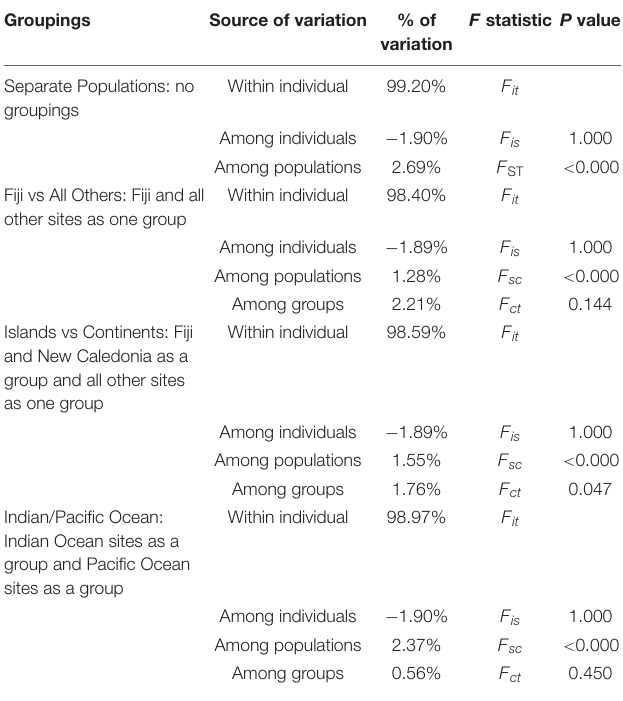
TABLE 4 | Summary of AMOVA results for the various